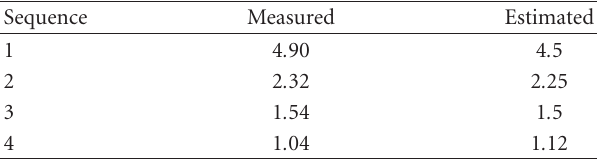
Table 4: Sequences and reduction of the